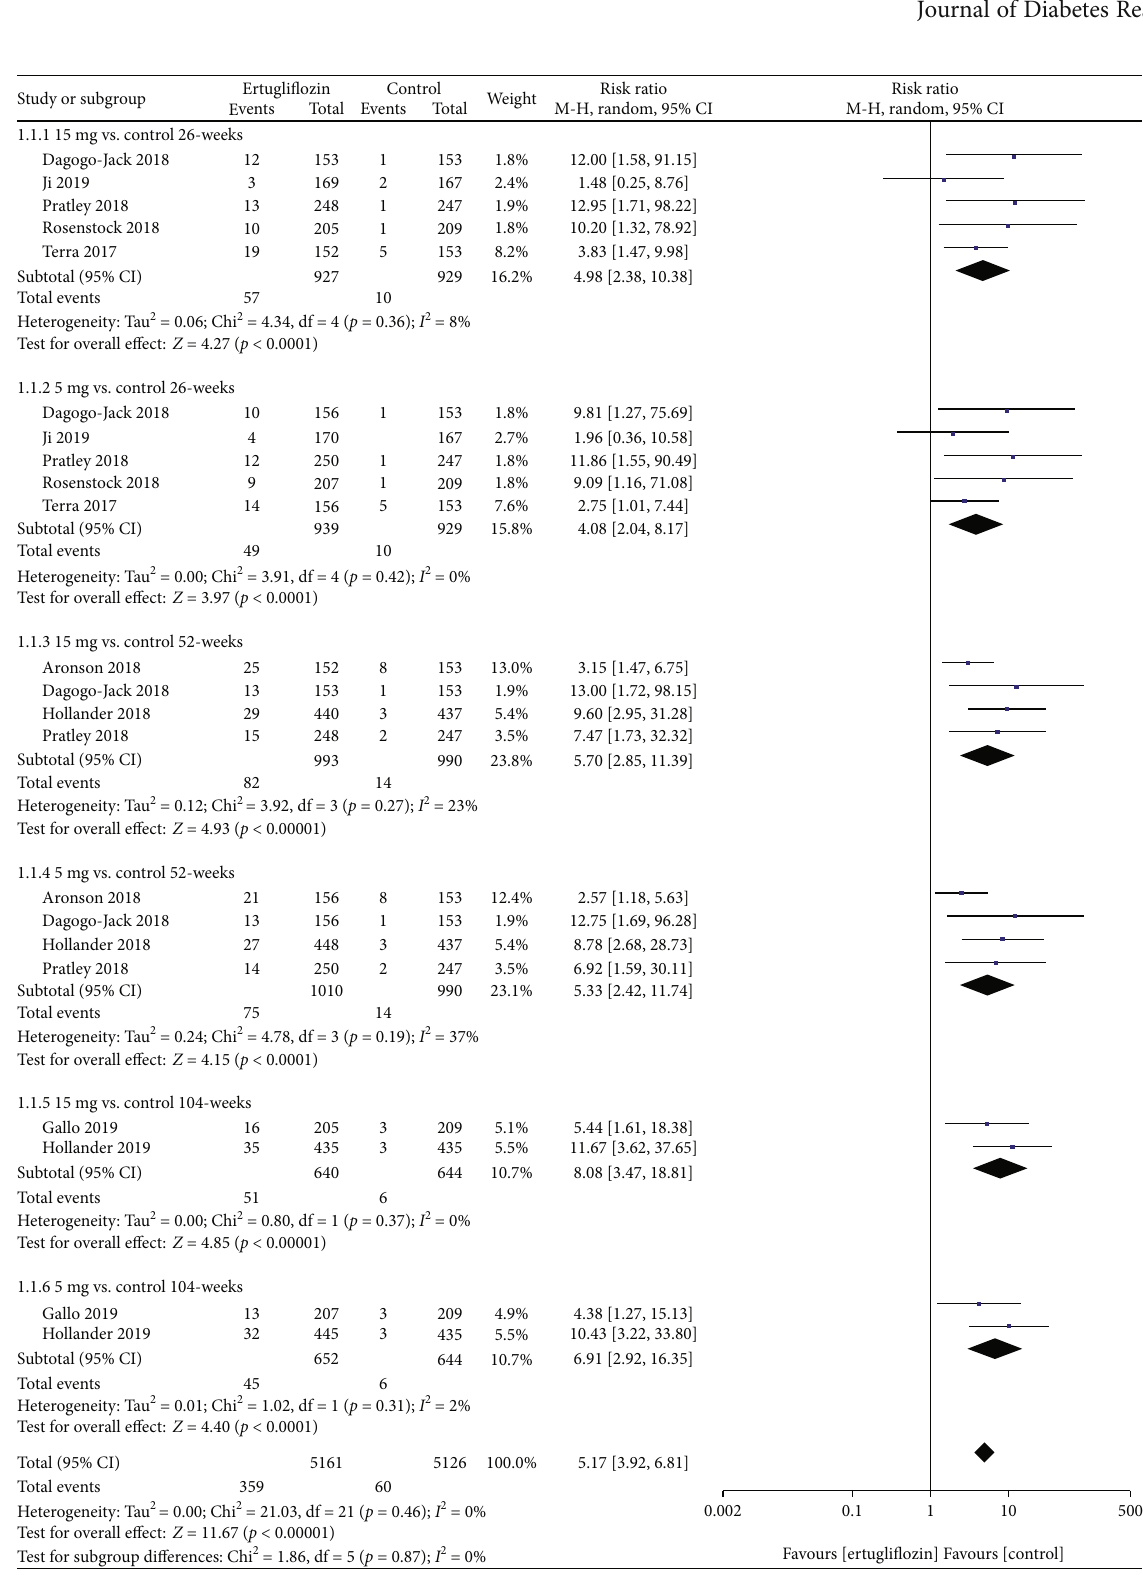
Figure 4: Forest plot of the risk of GMIs in the 15mg and 5mg dose groups compared with that in the control group at 26, 52, and 104 weeks. CI: con fi dence interval; M-H: